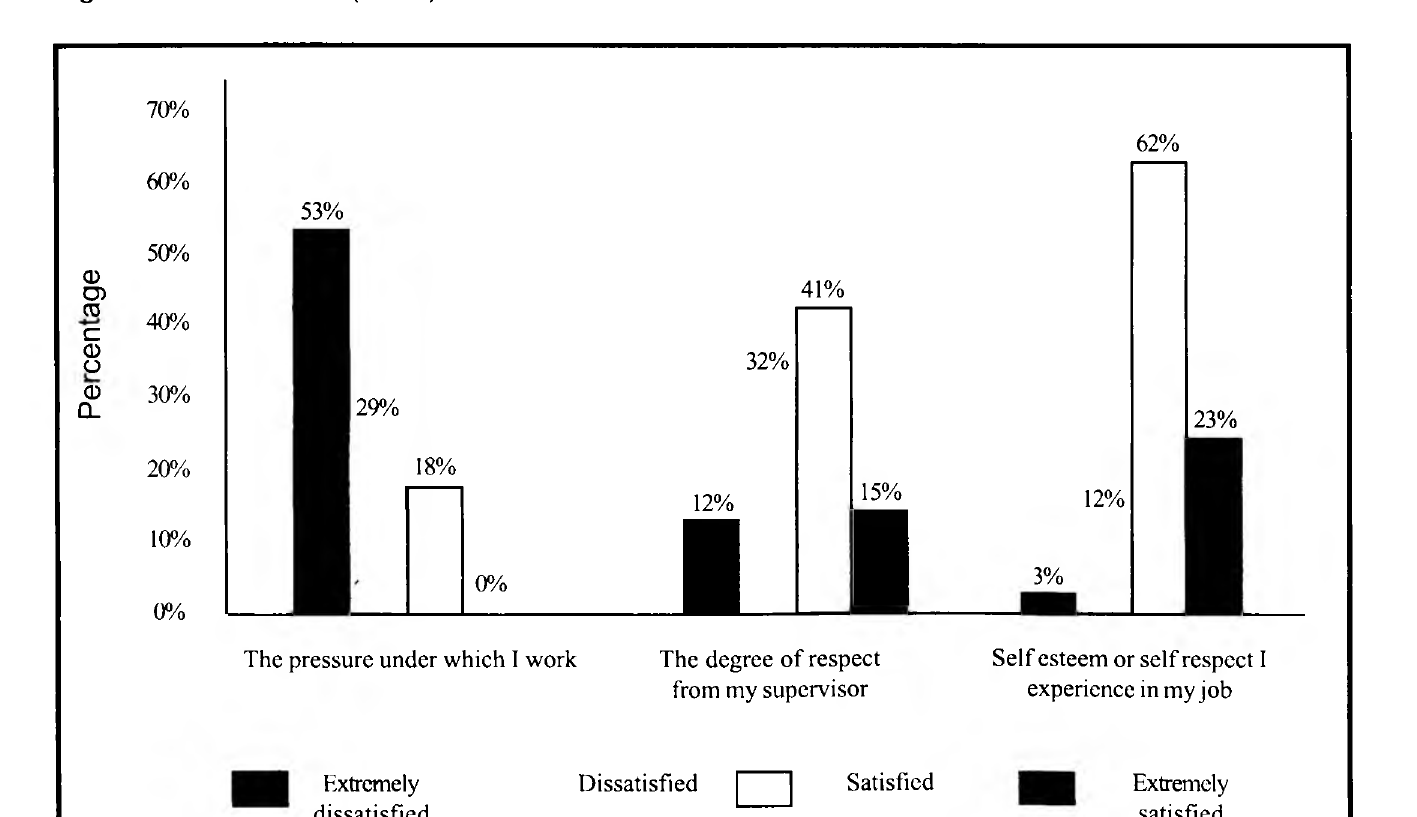
Figure 6: Selfesteem